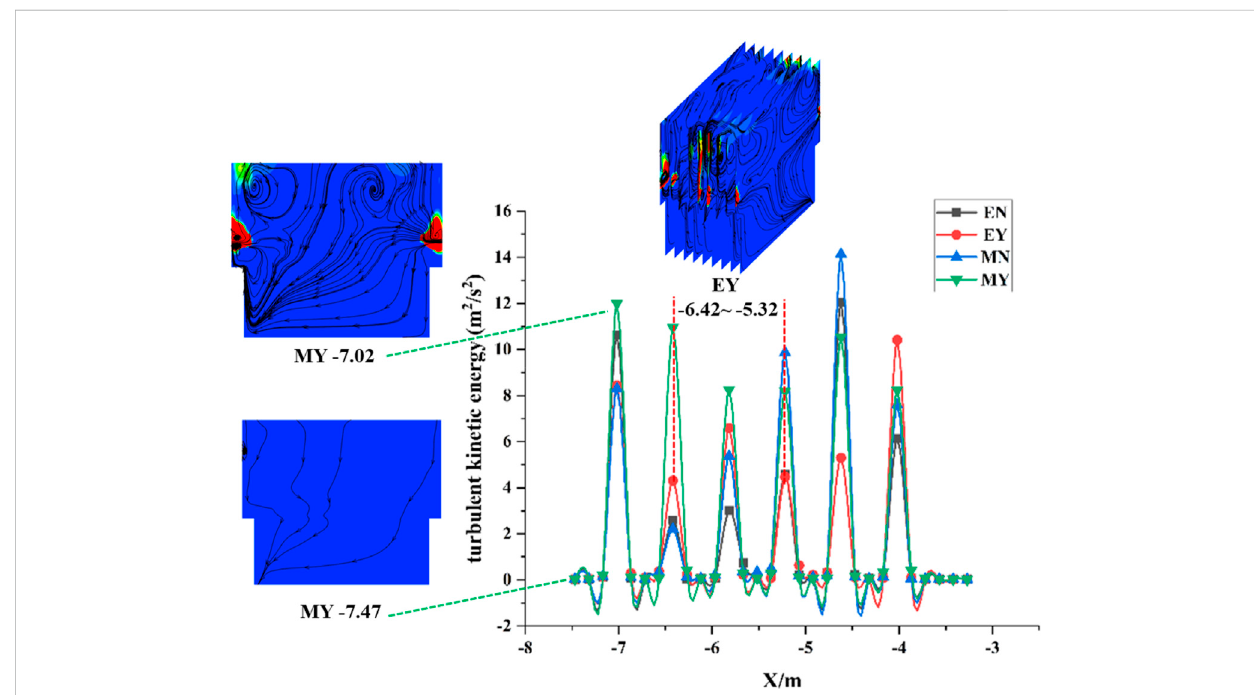
FIGURE 12 Variation curve of turbulent kinetic energy along the furnace length at 3 s under four cases.